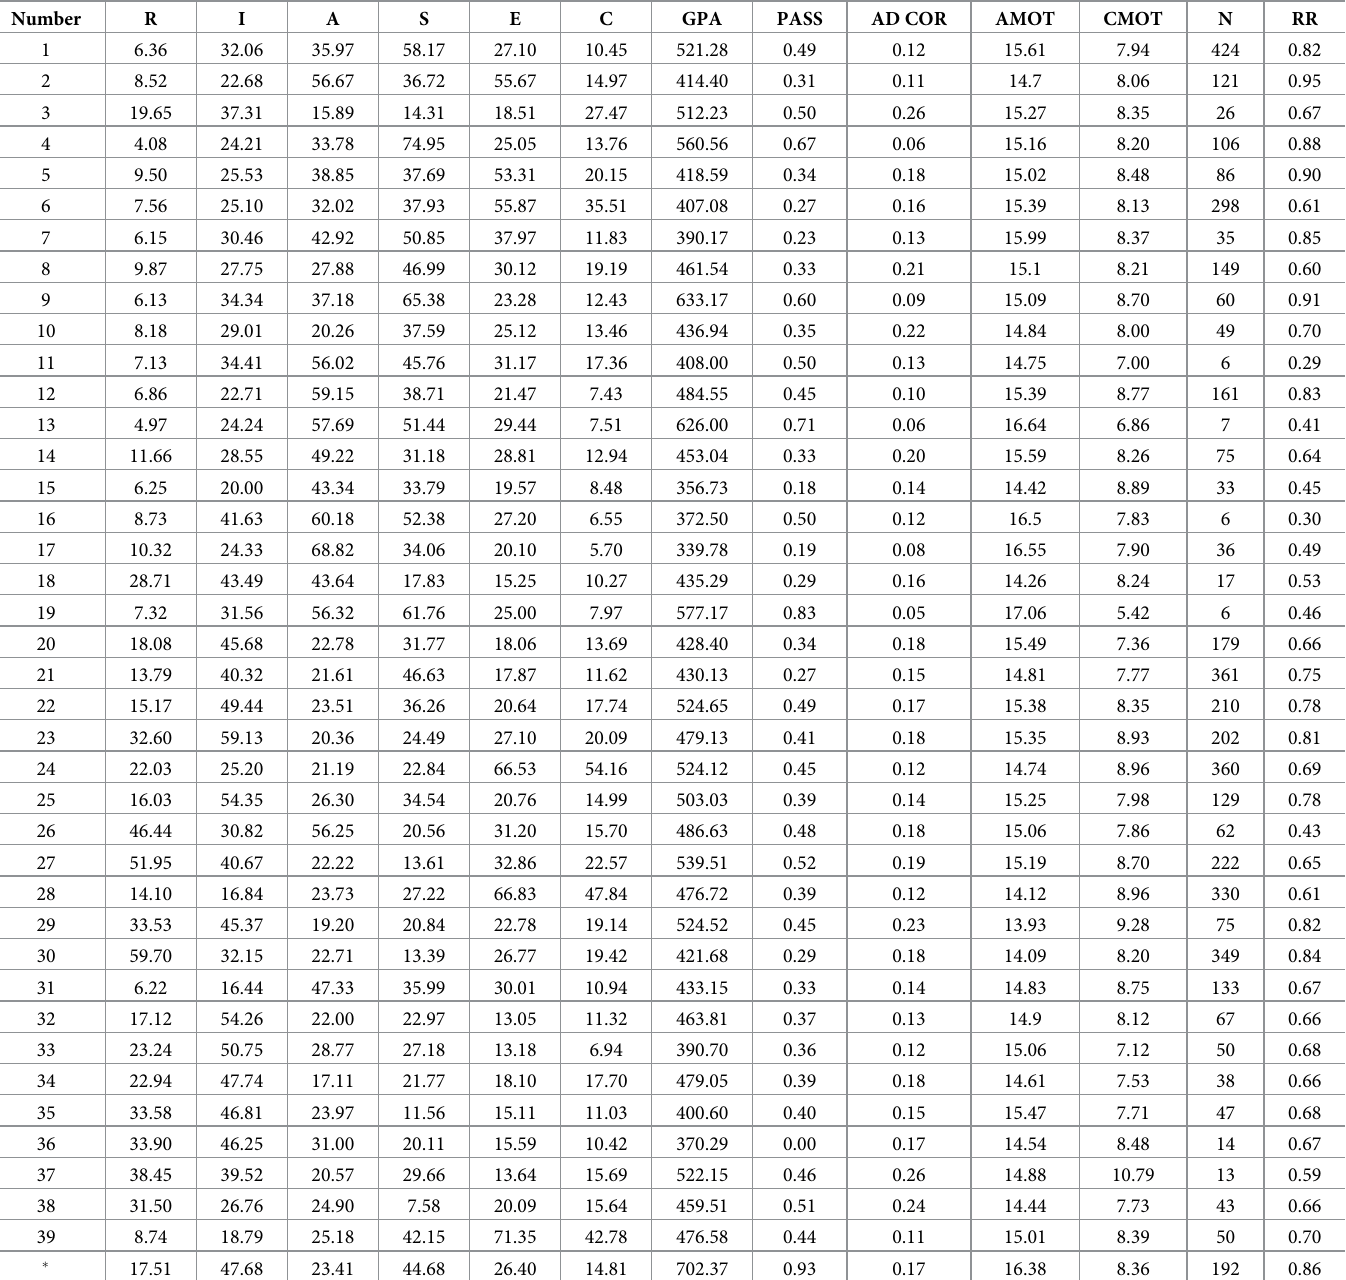
Table 2. Descriptive statistics for all study